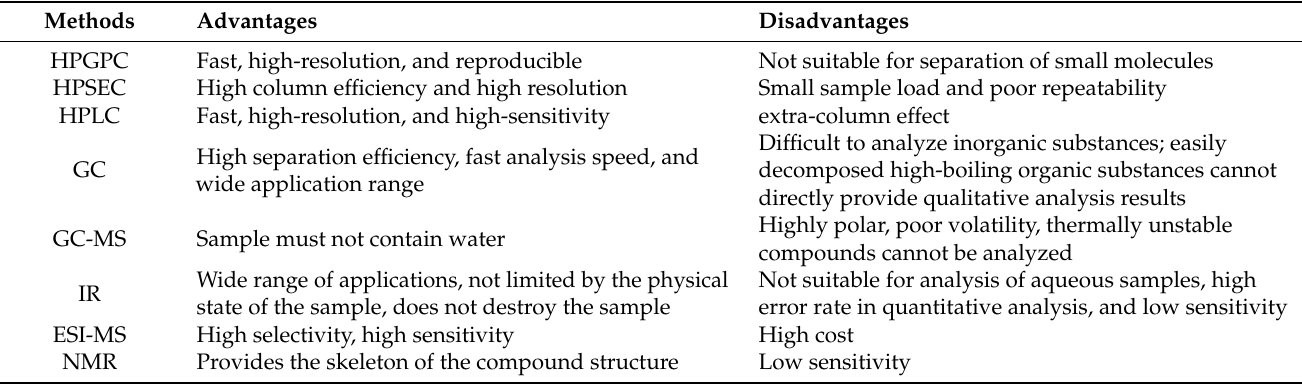
Table 3. Advantages and disadvantages of instrumental analysis methods for